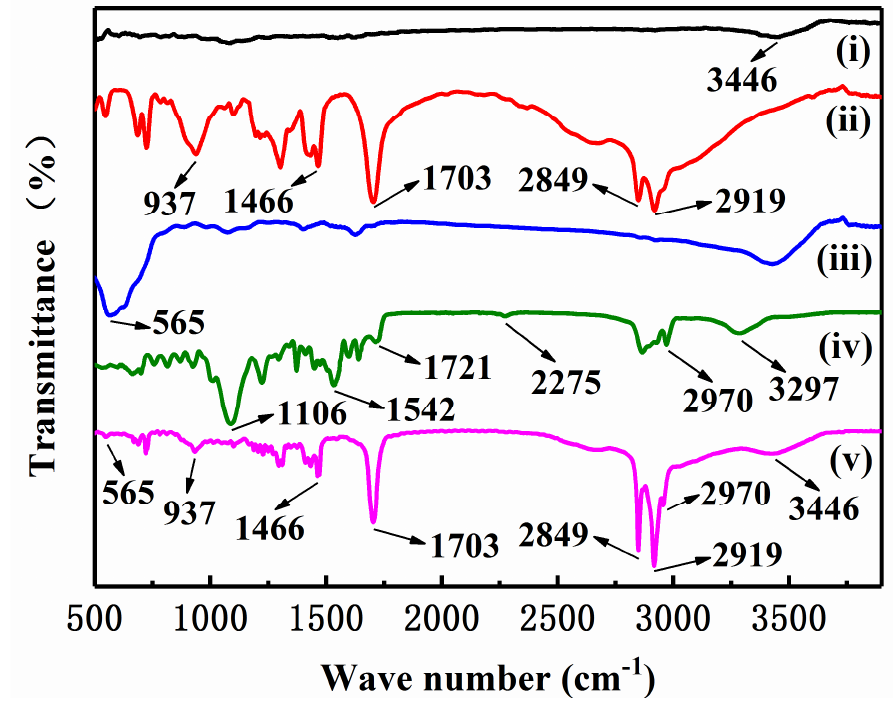
Figure 5. FT-IR spectra of ( i ) expanded graphite, ( ii ) stearic acid, ( iii ) Fe 3 O 4 nanoparticles, ( iv ) original polyurethane sponge, and (v) composite sponge sample 2.